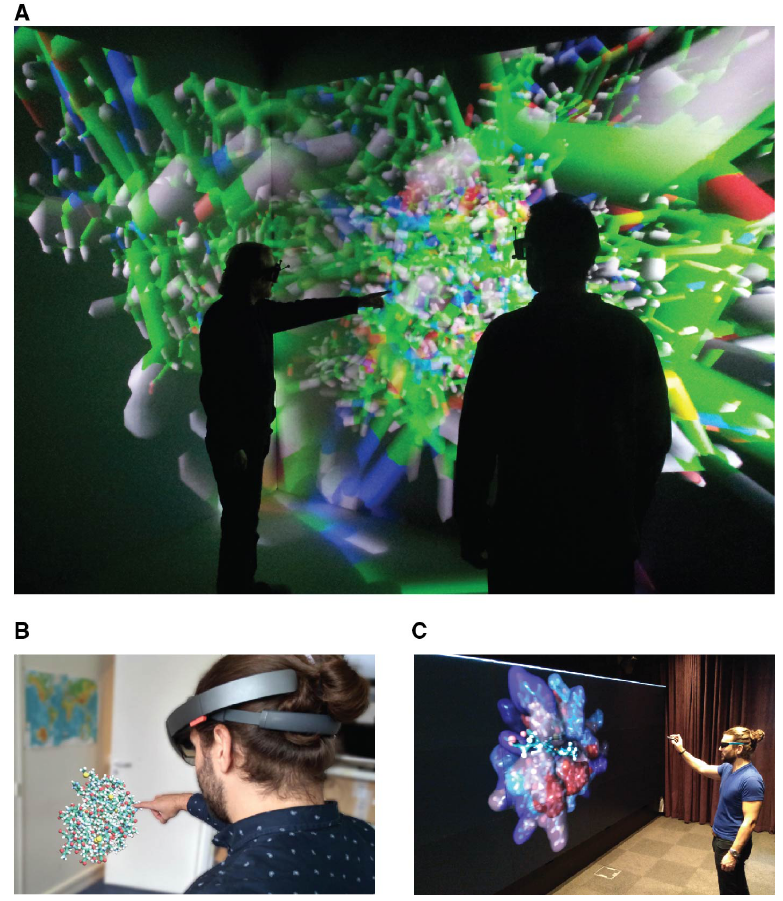
Figure 1: Immersive, augmented reality, and screen wall environments used for molecular visualization: (A) EVE plat- form, a multi-user CAVE-system composed of 4 screens (LIMSI-CNRS/VENISE team, Orsay), (B) Microsoft Hololens and (C) screen wall of 8.3 m 2 composed of 12 screens at full HD resolution with 120 Hz refresh rate in stereoscopy (IBPC- CNRS/LBT,